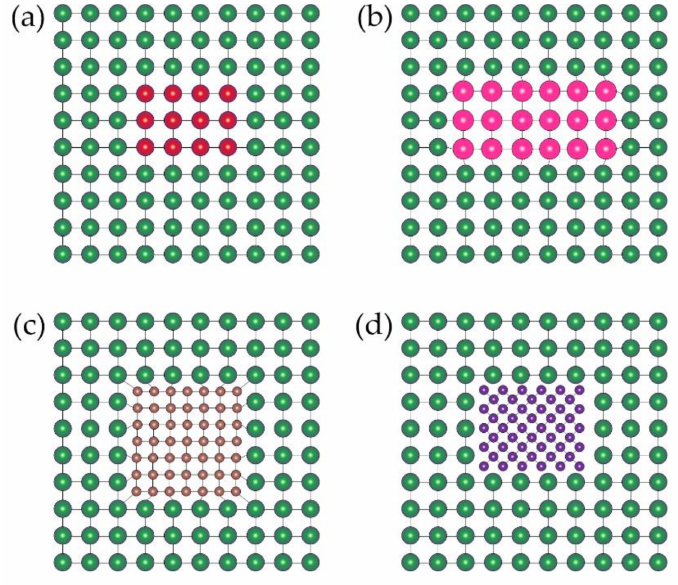
Figure 2. Schematic diagram of precipitation sequence of aluminum alloys: ( a ) Guinier-Preston zone; ( b ) coherent metastable phase; ( c ) semi-coherent metastable phase; ( d ) non-coherent equilibrium